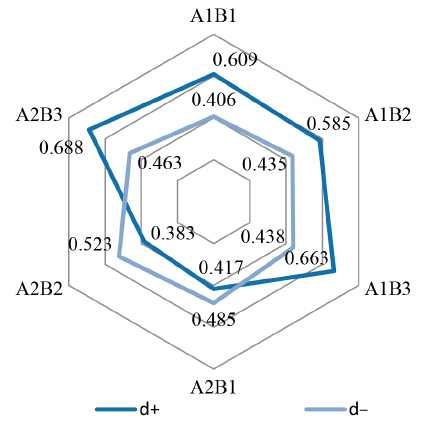
Figure 6 Evaluation of d+ and d–